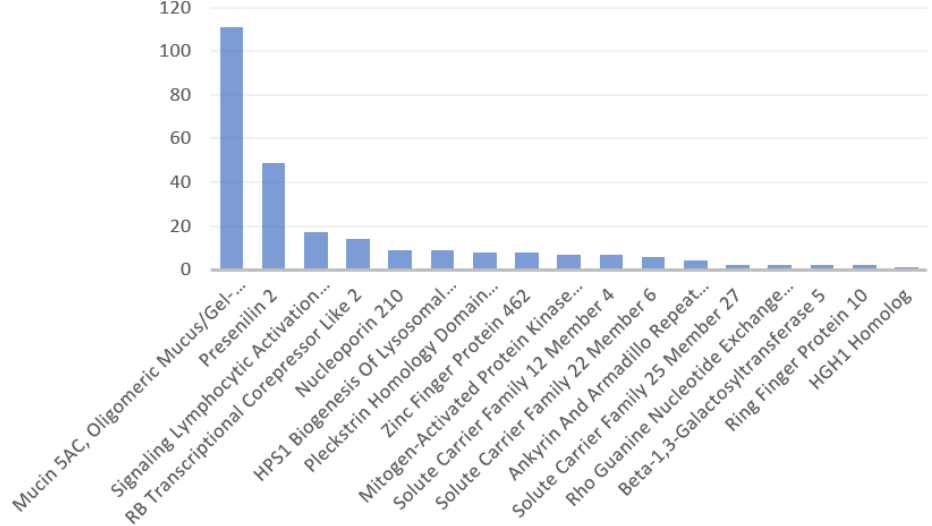
Figure 3. Number of disorders associated with the identified human proteins in descending order. Mucin is outstanding with the highest number of associated disorders, compared to the other proteins with the respective data (Appendix A, Table A1).